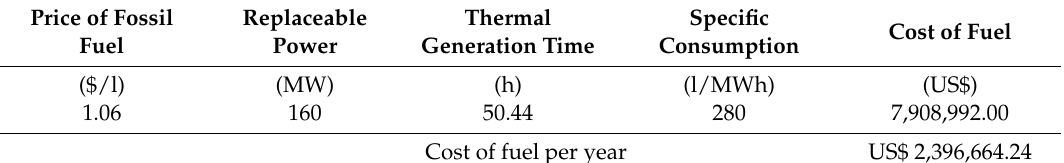
Table 10. Cost of fuel for thermal generation per year.